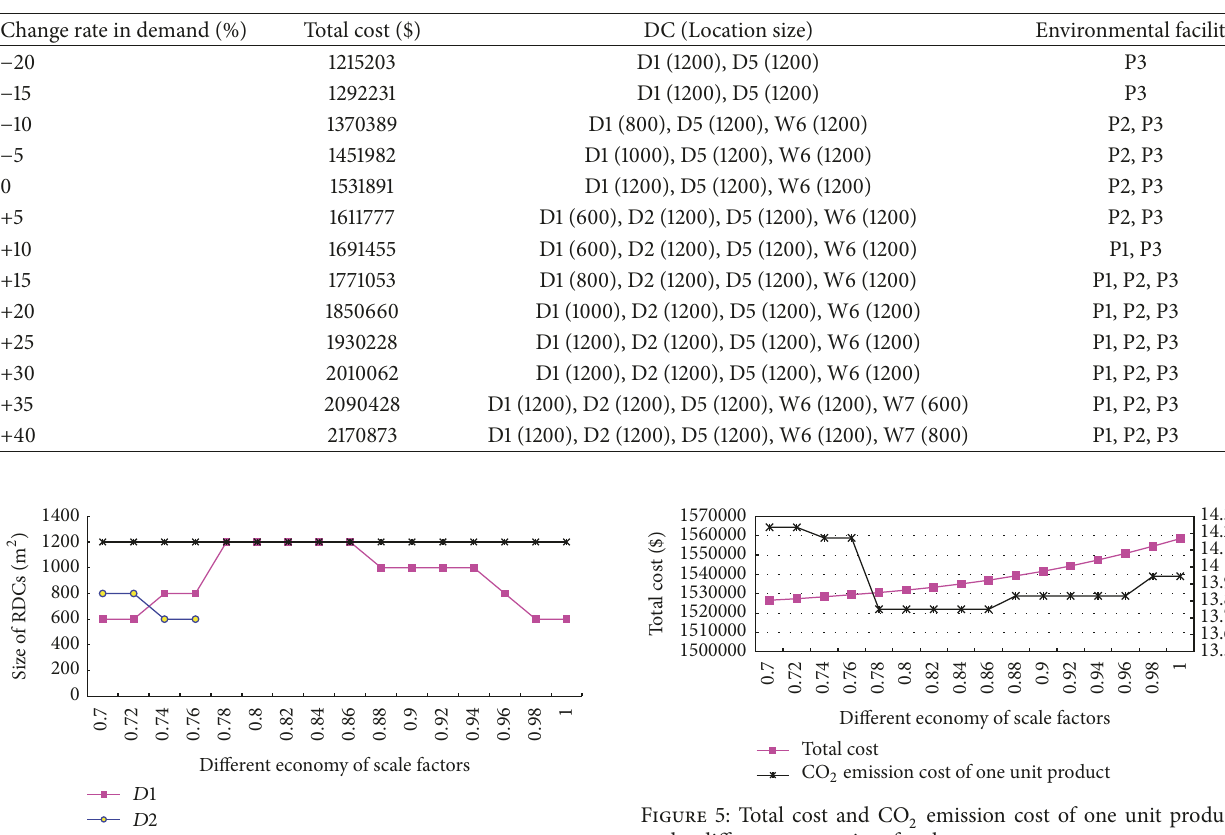
Table 10: Comparison based on different demands of customers.